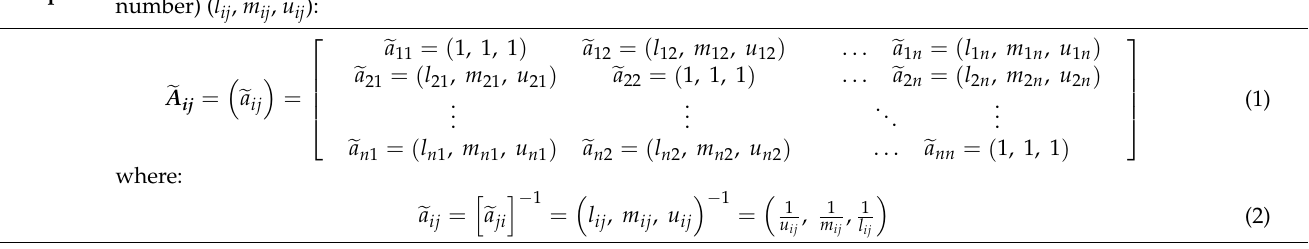
Table 4. Calculation algorithm of modified EA FAHP method, developed based on